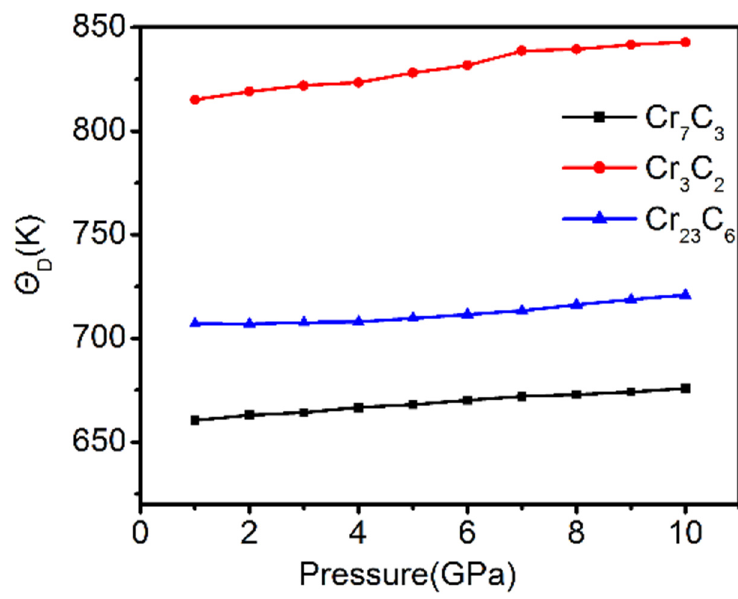
Figure 12. Θ D of binary chromium carbides under external